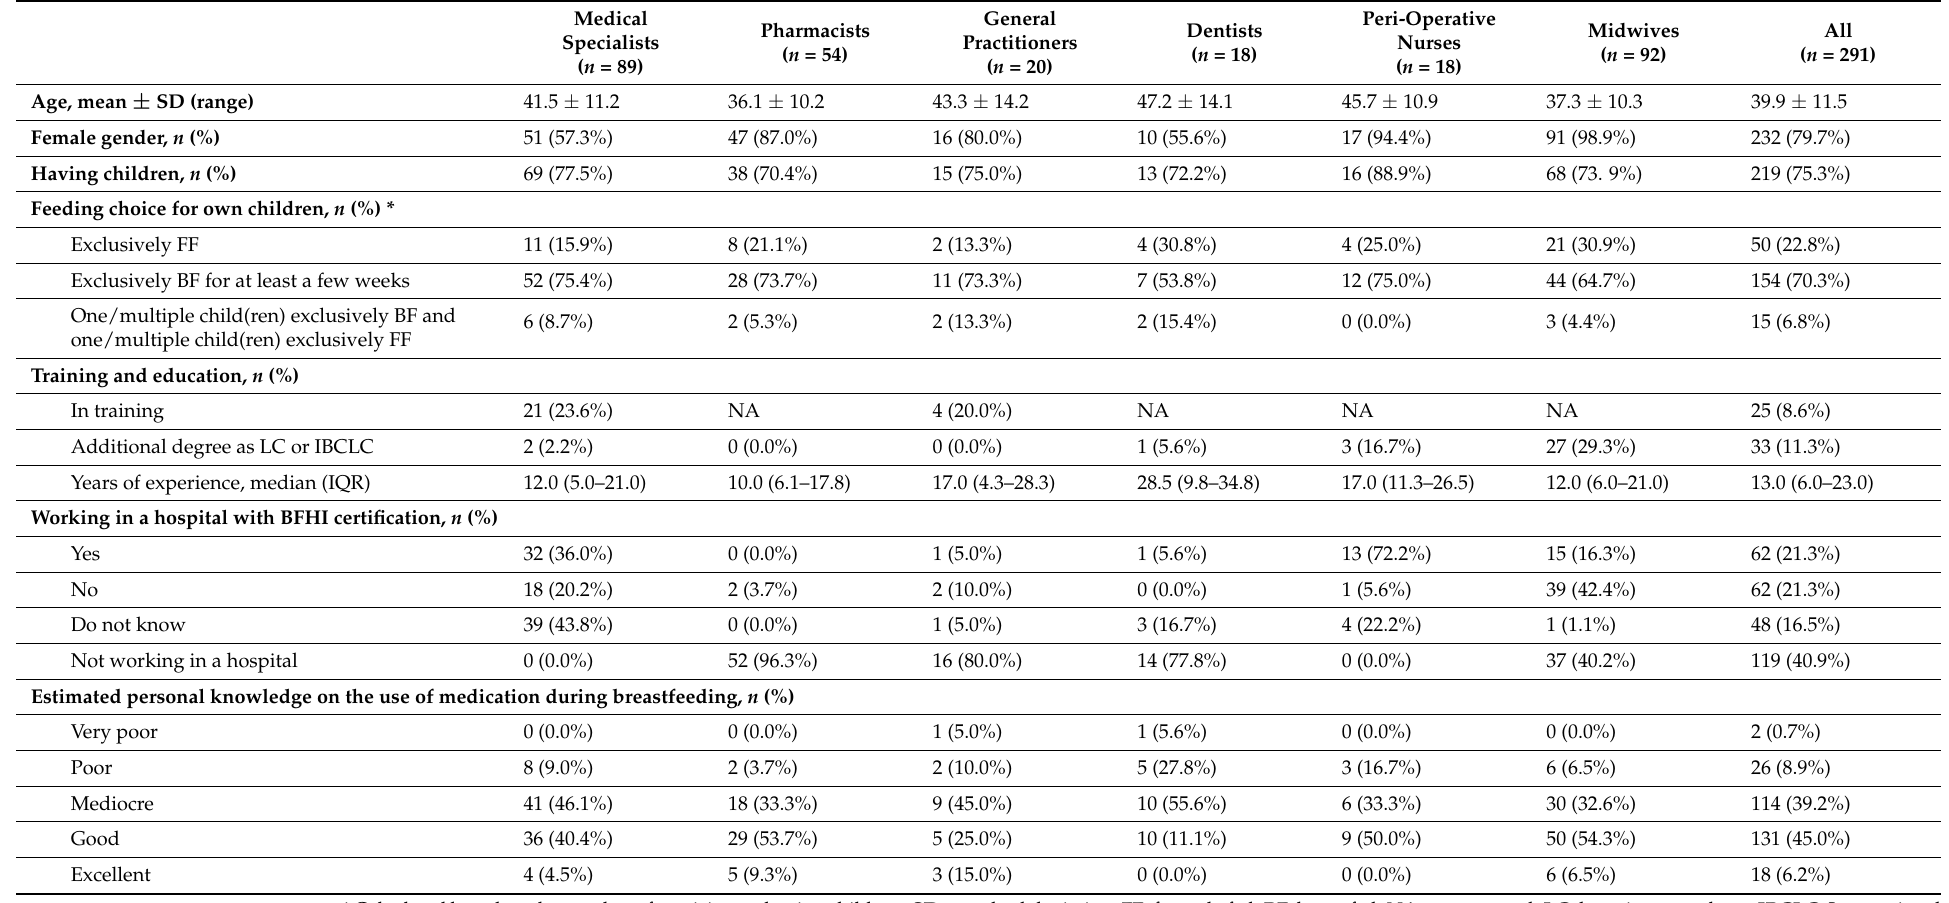
Table 1. Demographic and basic data of health care